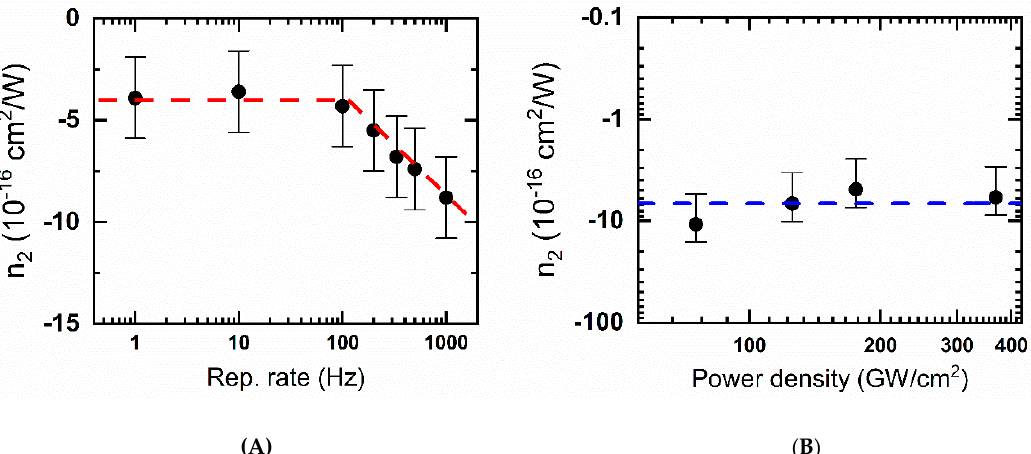
Figure 3. ( A )—QD nonlinear refraction index measured in range of peak repetition rate of 1 Hz–1000 Hz, red line is given as a guide to the eye; ( B )—QD nonlinear refractive index (NRI) is independent of incident power